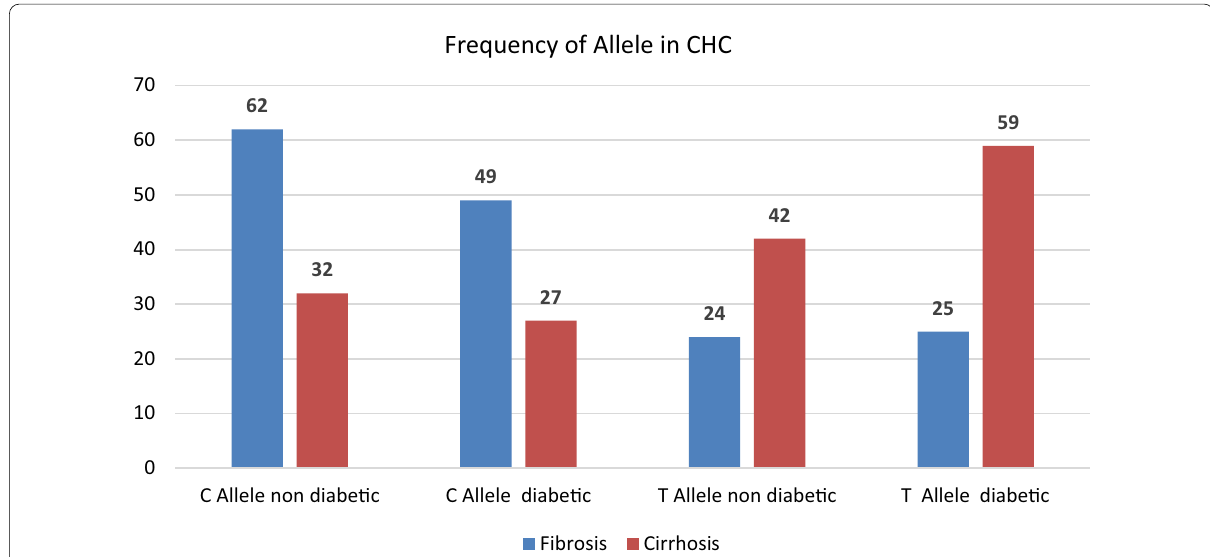
Fig. 1 Frequency of allele in chronic hepatitis C (fibrosis vs cirrhosis). This figure shows numerical distribution of C and T Alleles in fibrosis versus cirrhosis in both diabetic and non‑diabetic CHC patients. It was noticed that T alleles were more frequent in diabetic patients with cirrhosis and more hepatic sequels, contrasted with C alleles which were more frequent in non‑diabetic patients with fibrosis